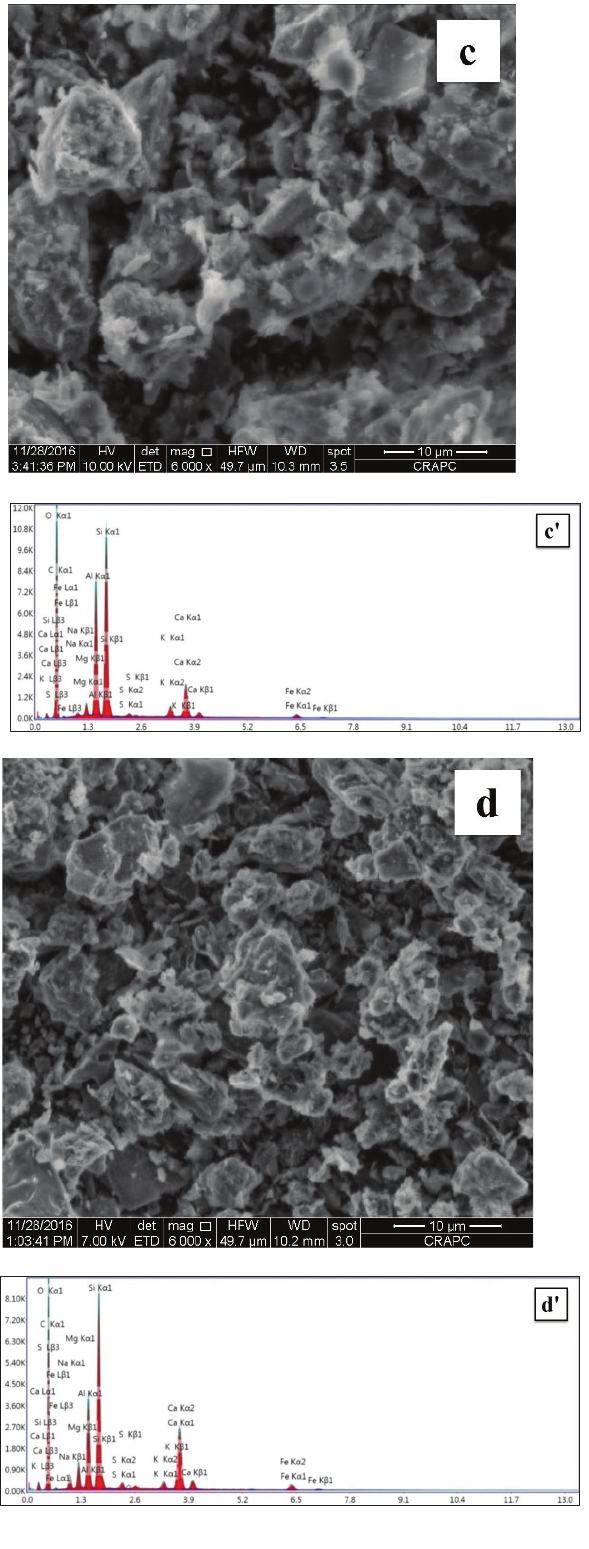
Figure 8. SEM and EDS analyses of the soil treated with various dosages of (10% bentonite+2%